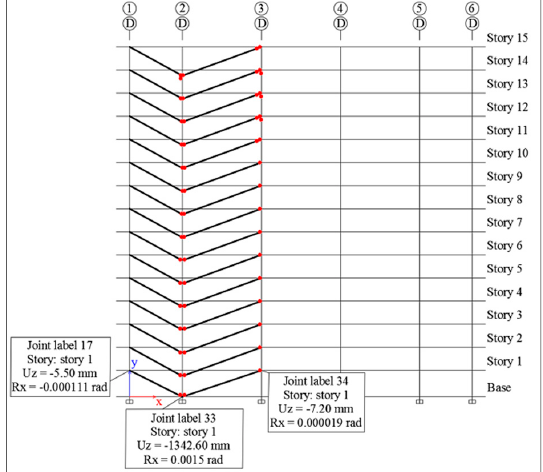
Figure 12. Displacement response at the location of the notionally removed column D2 when Moment frames are located at perimeters and along grid lines B, C, D, E, F and G (non-linear static case 18).